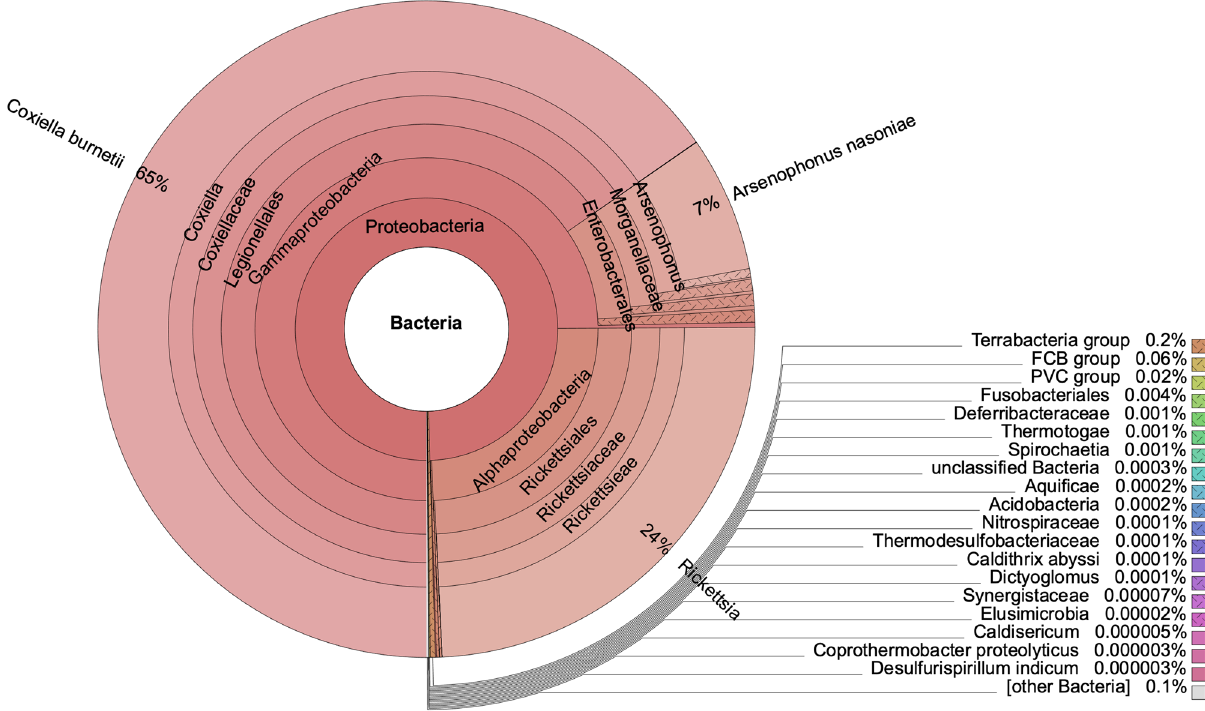
Figure 3. Metagenomics analysis of bacterial group in sequenced RMSF vaccine.